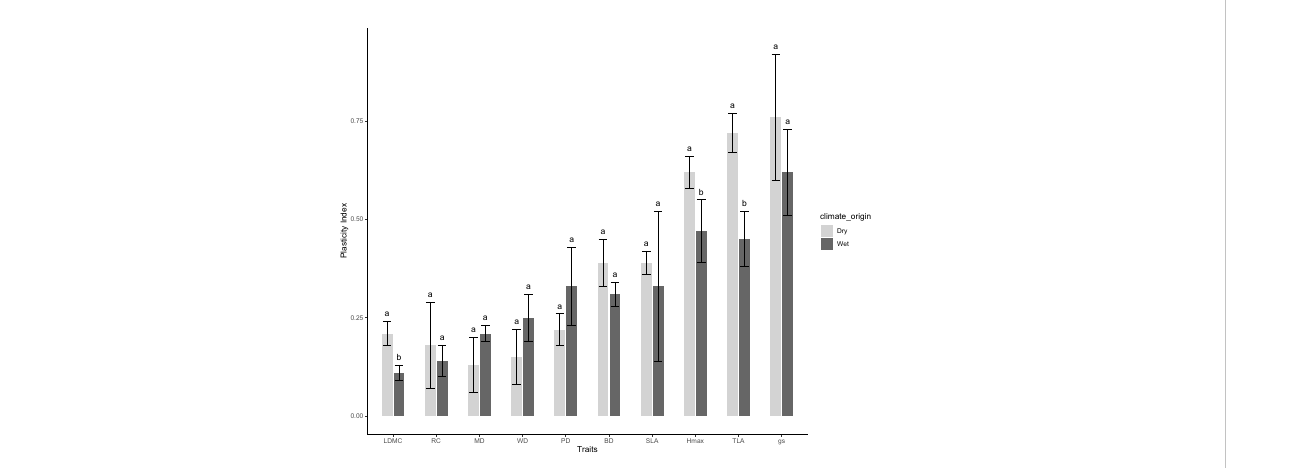
FIGURE 4 Variation in phenotypic plasticity between wet and dry climate-origin. H max = maximum plant height, gs = stomatal conductance, WD, wood density; PD, predawn water potential; MD, midday water potential; TLA, total leaf area; SLA, speci fi c leaf area; BD, basal diameter and LDMC, leaf dry matter content. Letter signi fi es differences in trait plasticity, while dark and grey colours represents wet and dry climate-origin,